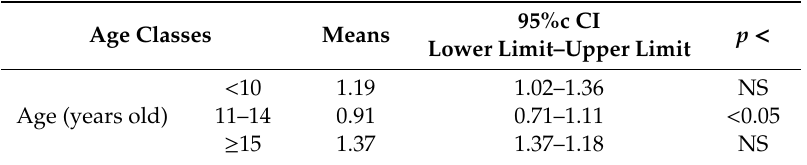
Table 4. Estimated means of log 15F 2t -IsoP by age class adjusted for log (total inactive BPA), log cotinine by means of piecewise non-linear